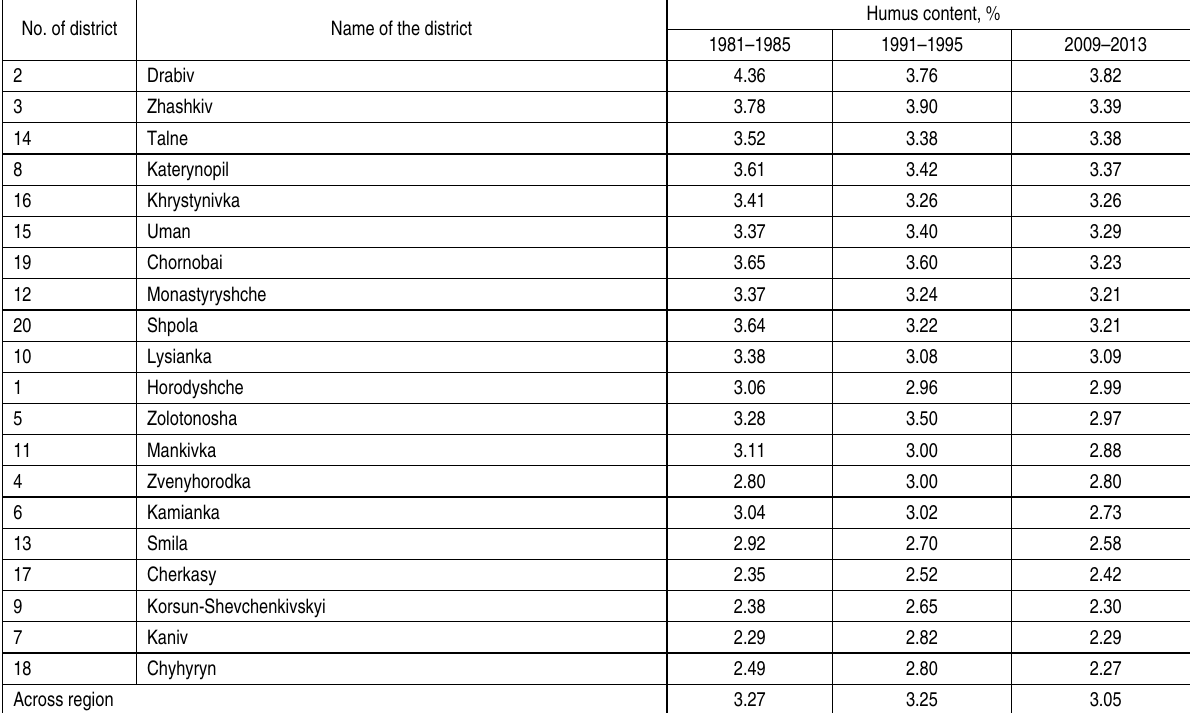
Table 4. Rating of districts of the Cherkasy region on the content of humus Source: Compiled based on Baliuk et al. (2017)